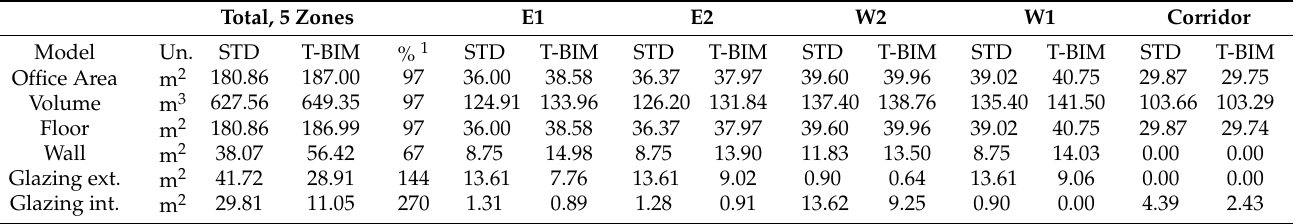
Table 4. Geometric values of the elements in the as-is STD and as-is T-BIM models, totals and for each one of the zones. (1) percentage surface concordance of zones between the models.